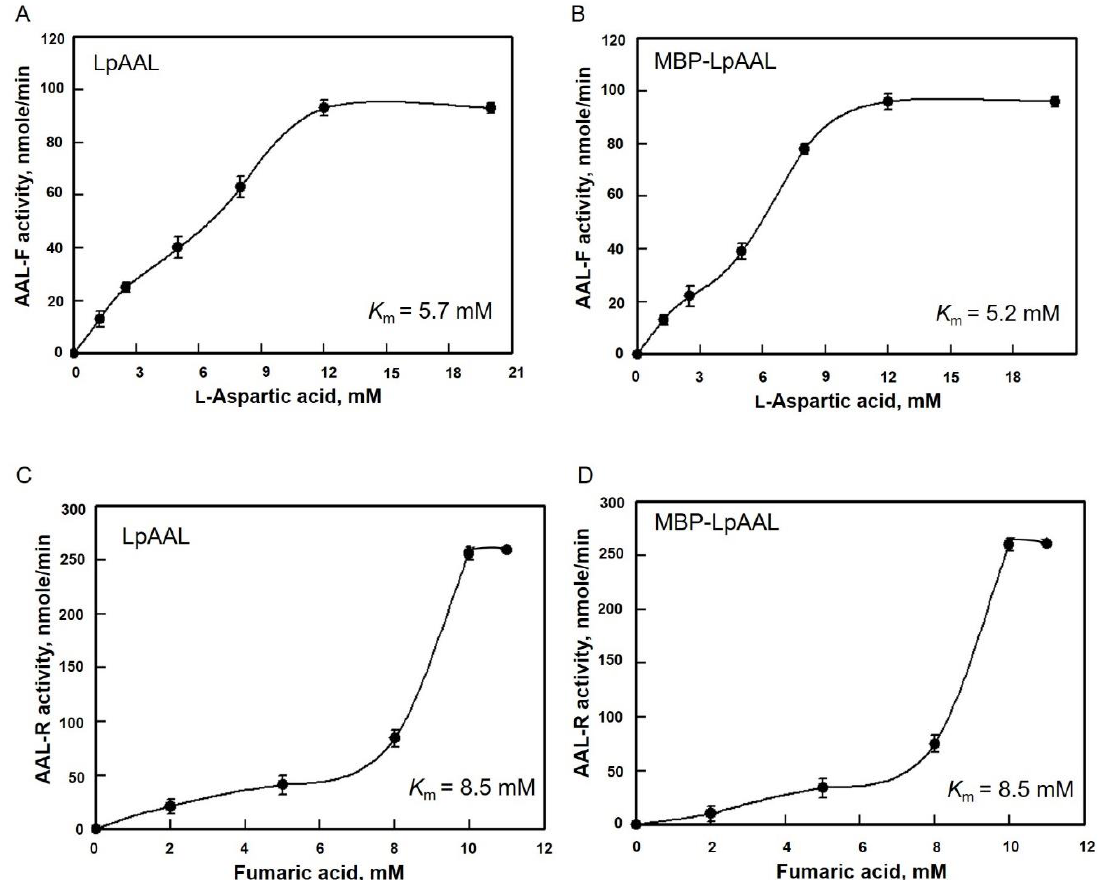
Figure 5. Kinetic parameters of LpAAL and MBP-LpAAL with L-aspartic acid and fumaric acid as substrate. ( A ), to determine LpAAL kinetic parameters using L-aspartic acid as substrate, substrate saturation curve. ( B ), to determine MBP-LpAAL kinetic parameters using L-aspartic acid as sub- strate, substrate saturation curve. ( C ), to determine LpAAL kinetic parameters using fumaric acid as substrate, substrate saturation curve. ( D ), to determine MBP-LpAAL kinetic parameters using